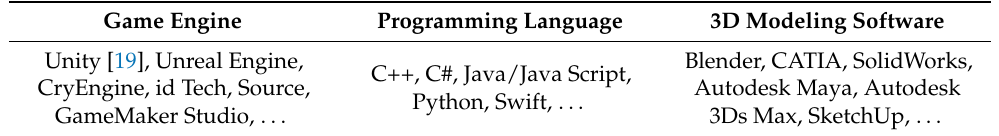
Table 1. Commonly used software for VR